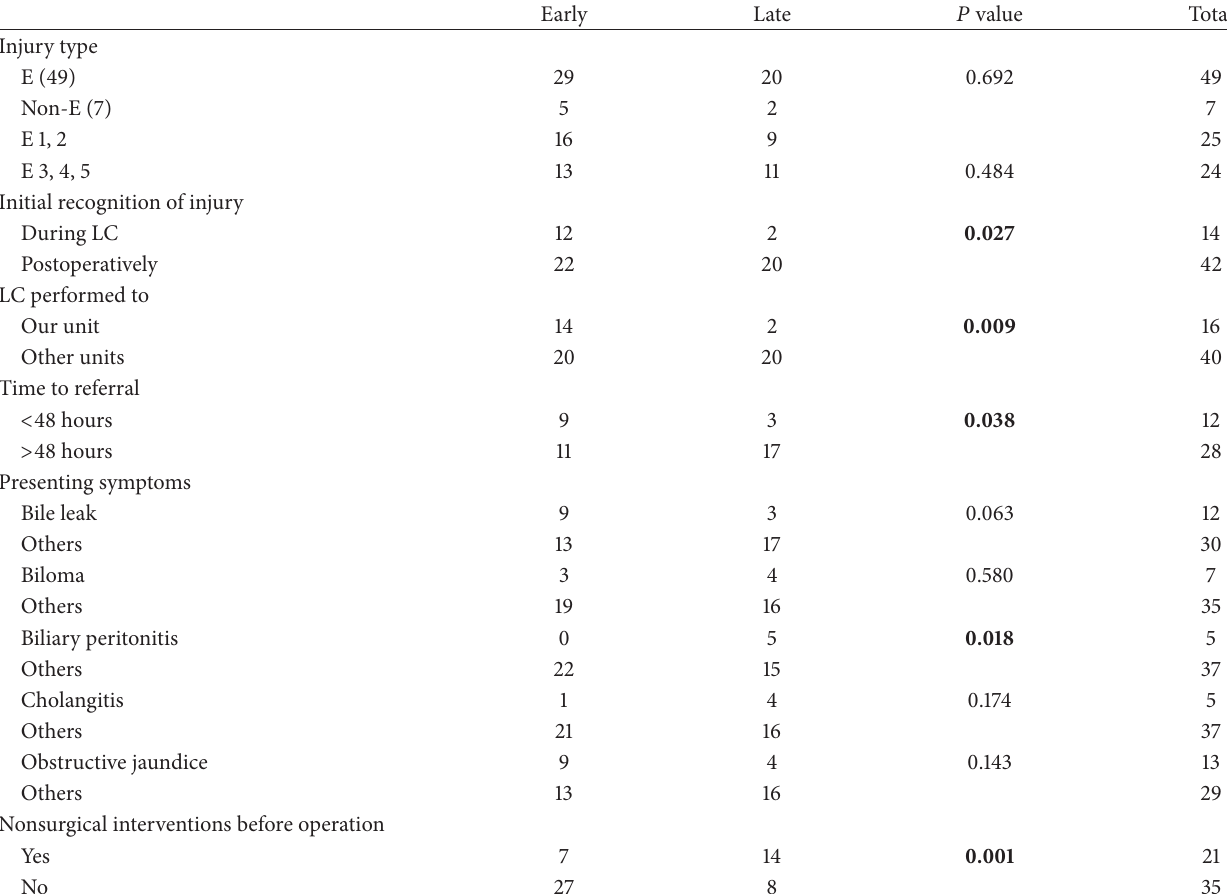
Table 6: Factors that potentially influenced the decision for early or late surgical intervention by